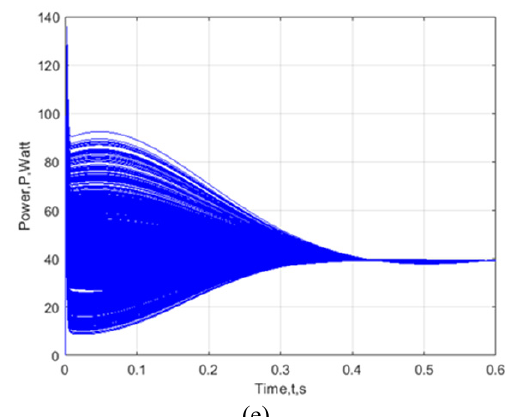
Figure 8 Magnetic suspension system profiles for 1000 Monte-Carlo trials; (a) ball position vs. time; (b)